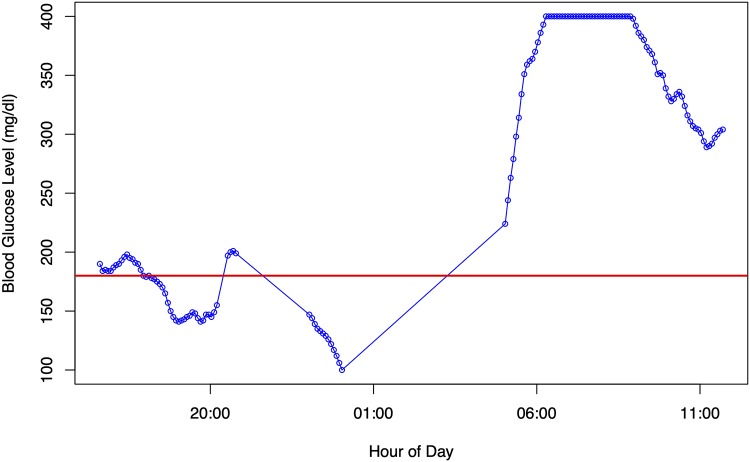
A sample of a few hours of CGM data from one patient.The horizontal red line indicates the boundry between normoglycemia and hyperglycemia according to [15]. Note (i) the two gaps in the trace, one shorter and one longer; and (ii) maximum possible sensor reading of 400 mg/dl, even though glucose levels can exceed this amount. This patient experienced hypoglycemia just after 1am followed by severe hyperglycemia later in the morning.